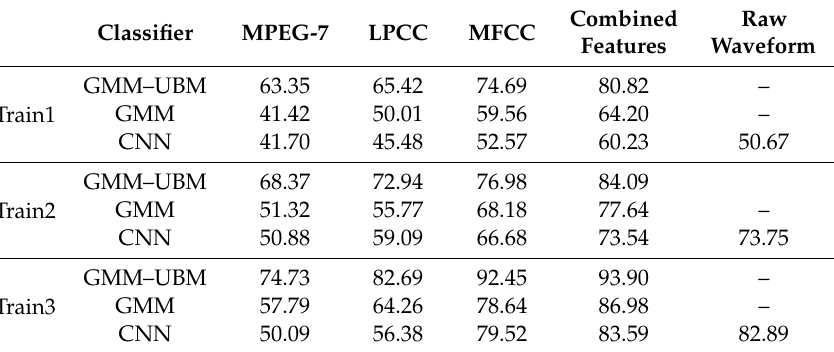
Table 7. F-macro of violin grade classification